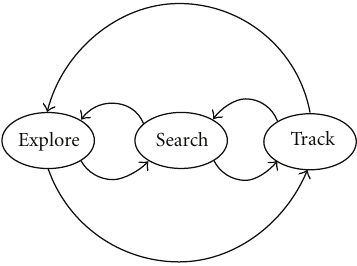
Figure 5: The path planning modes that may exist when surveil- lance is performed by region-based planning.